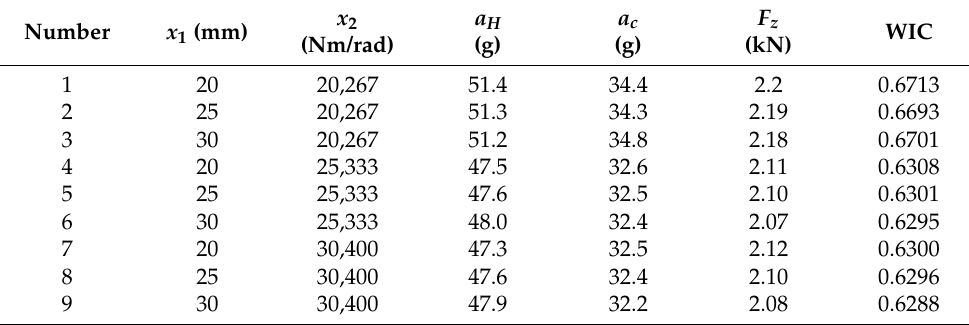
Table 2. Experimental scheme and simulation results.